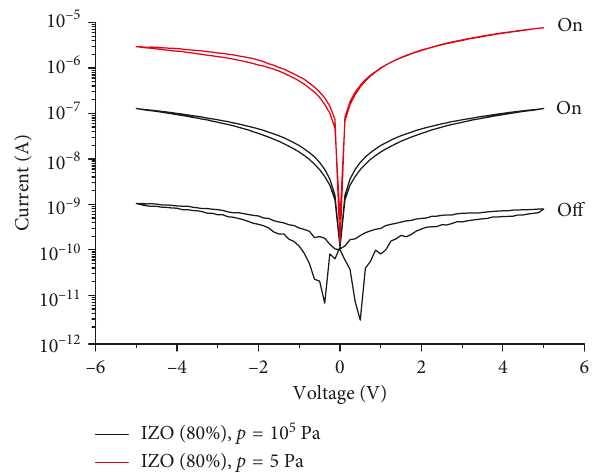
Figure 8: I - V characteristics of sample IZO3 in air (“on,” black curve) and in vacuum (“on,” red curve) at UV irradiation and in darkness (“off,” lower